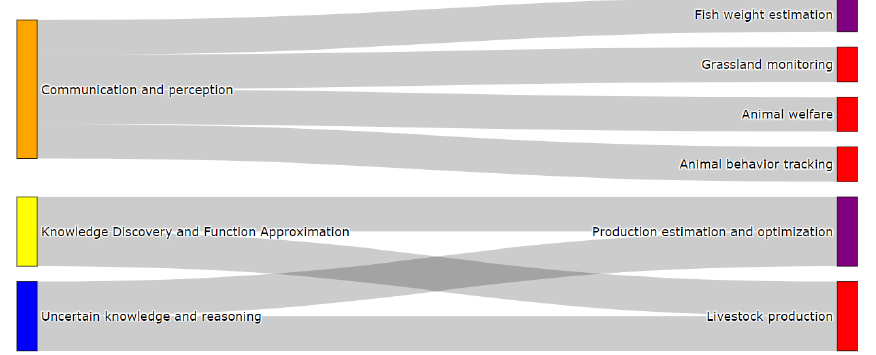
Figure 10. Fish farming and livestock problems classified by the proposed